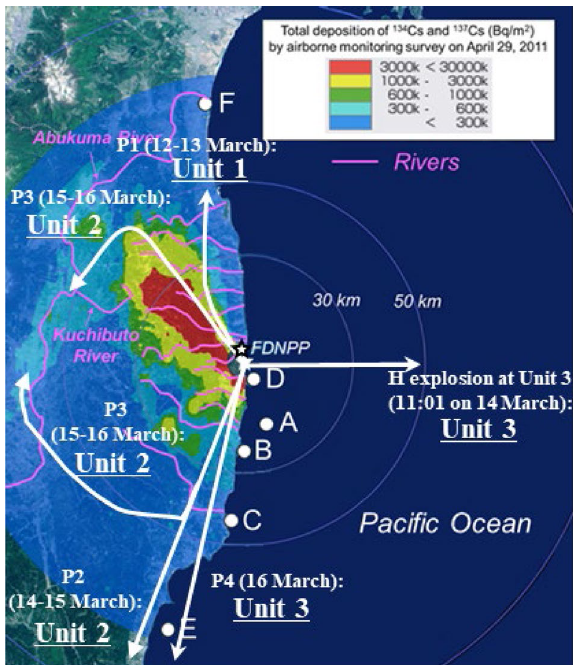
Figure 5. Transport routes of plumes possibly including CsMPs. The date of plume was cited from Tsuruta et al. 26 , and the transport route was cited from Nakajima et al. 25